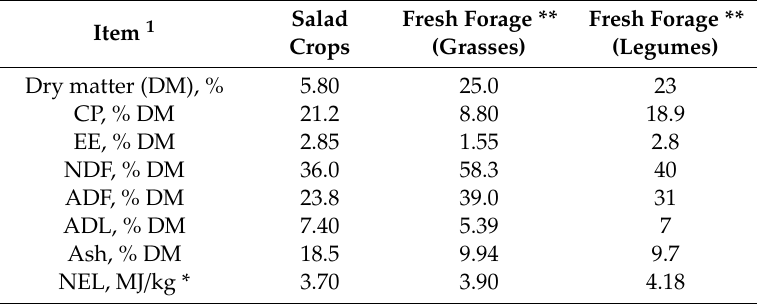
Salad Fresh Forage ** Fresh Forage ** Crops (Grasses) (Legumes)